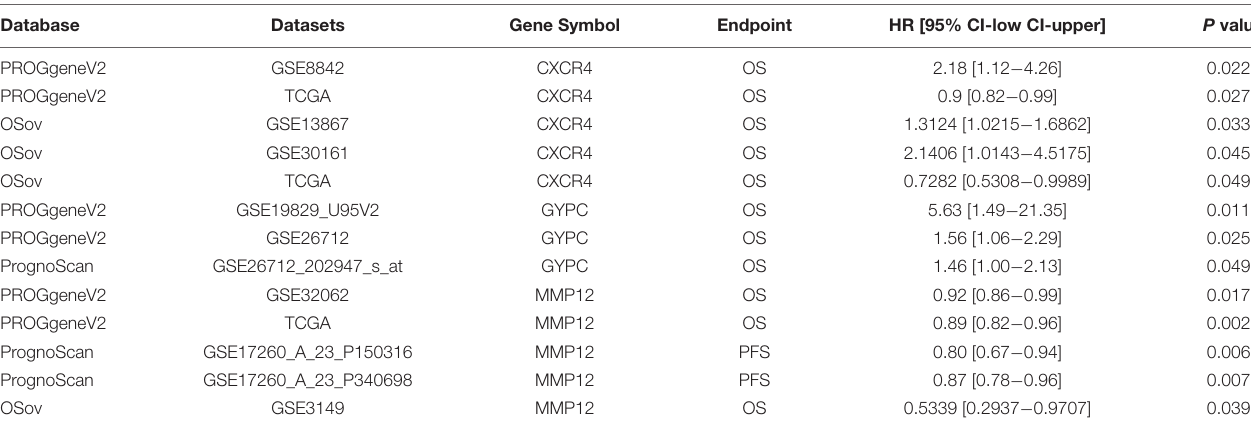
TABLE 2 | Confirmation of prognostic value of three hub